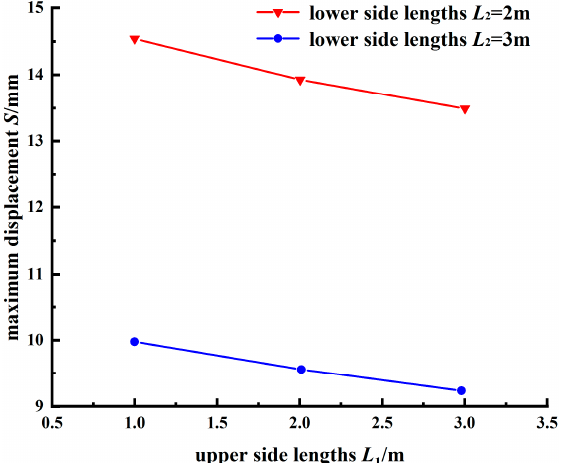
Figure 15. Maximum displacement of tunnel portal corresponding to different upper side lengths of the trapezoidal freezing soil mass.